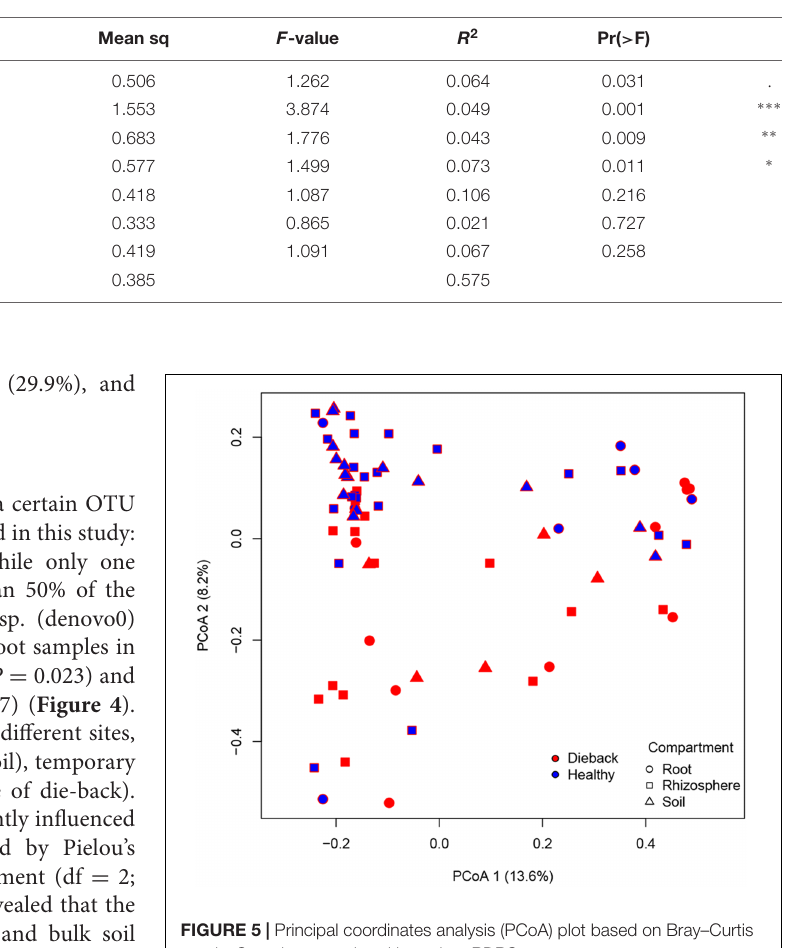
the structure (beta diversity) of oomycetes communities. The factors that were found to be significant in explaining the diversity were die-back occurrence ( R 2 = 0.049, P = 0.001), compartment ( R 2 = 0.043, P = 0.009), and the interaction between lake and die-back occurrence ( R 2 = 0.073, P = 0.011) ( Table 1 ). Among the heavy metals, only cadmium concentration (mg · Kg − 1 ) is significantly related to oomycetes distribution ( R 2 = 0.035, P = 0.002) ( Table 2 ). In support of this, a PCoA plot revealed clustering based on the plant health status, demonstrating the importance of die-back in explaining the diversity of oomycetes ( Figure 5 ).